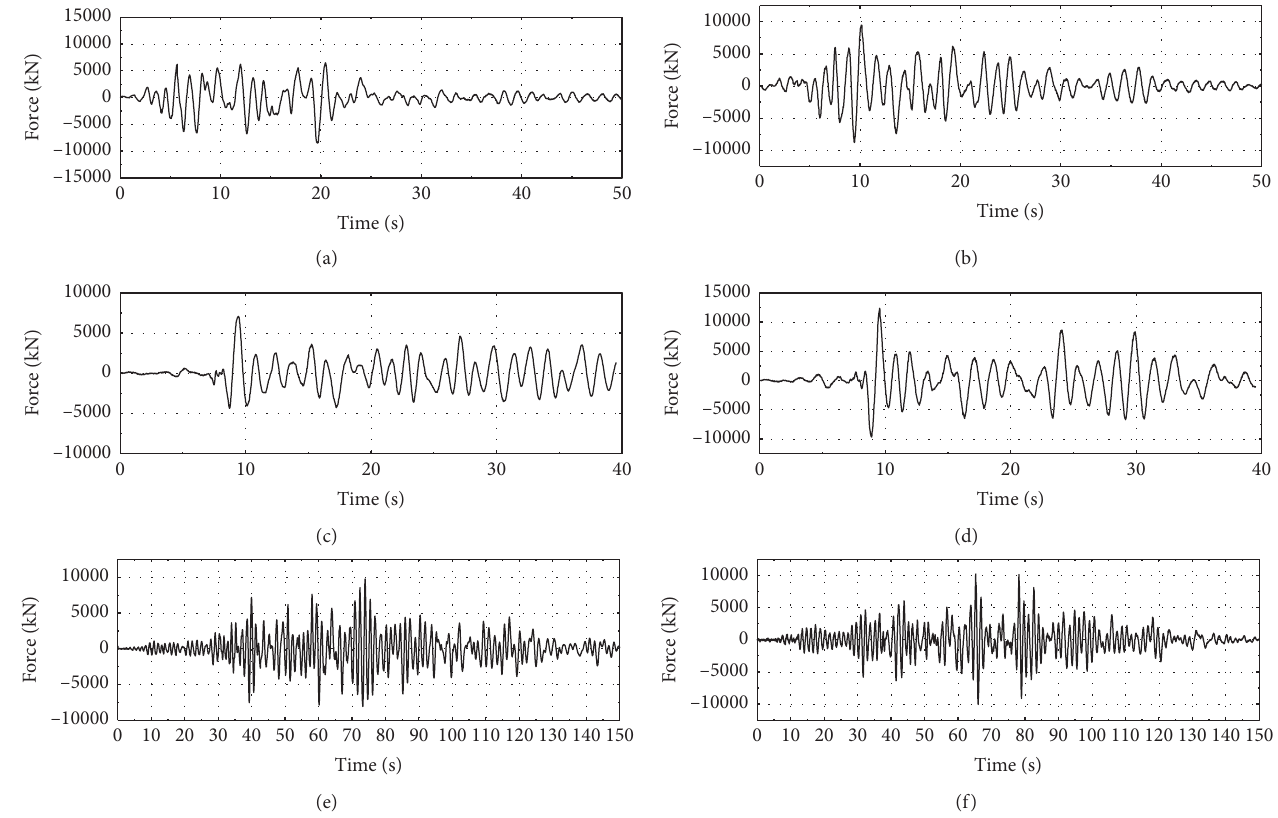
Figure 12: Force seismic response time-history curves. (a) Artificial synthetic-condition 1-transverse. (b) Artificial synthetic-condition 2- longitudinal. (c) Imperial Valley-condition 3-transverse. (d) Imperial Valley-condition 4-longitudinal. (e) Alaska-condition 5-transverse. (f) Alaska-condition